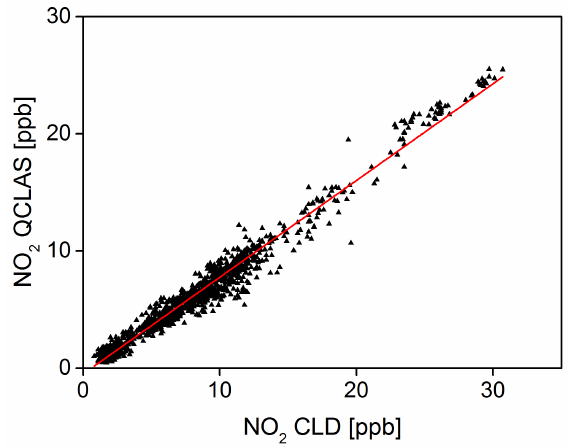
Figure 5. Determination of the instrument precision and stability: time series of zero-air (red) and detector dark-noise (black) and the associated Allan deviation plots. The detector dark-noise trace in the top graph is offset by 1.5ppb from zero for clarity.